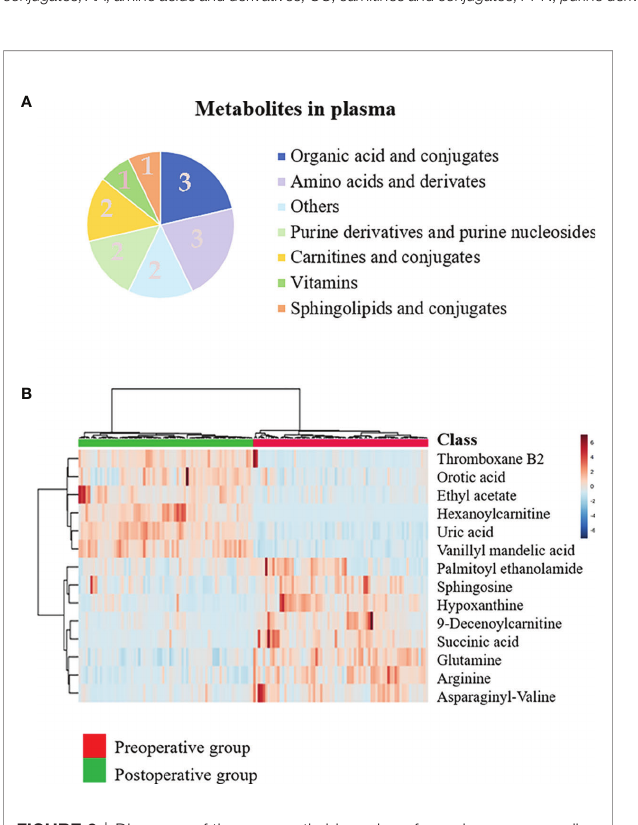
FIGURE 2 | Discovery of the prognostic biomarkers for oral squamous cell carcinoma (OSCC) in plasma metabolomics. (A) Pie chart summarizing the taxonomic annotation of differentially expressed metabolites in the preoperative group vs. postoperative group (numbers in the pie chart represent the number of metabolites). (B) Heatmap representing the relative levels of 14 signi fi cantly different metabolites in the plasma samples of the preoperative group and postoperative